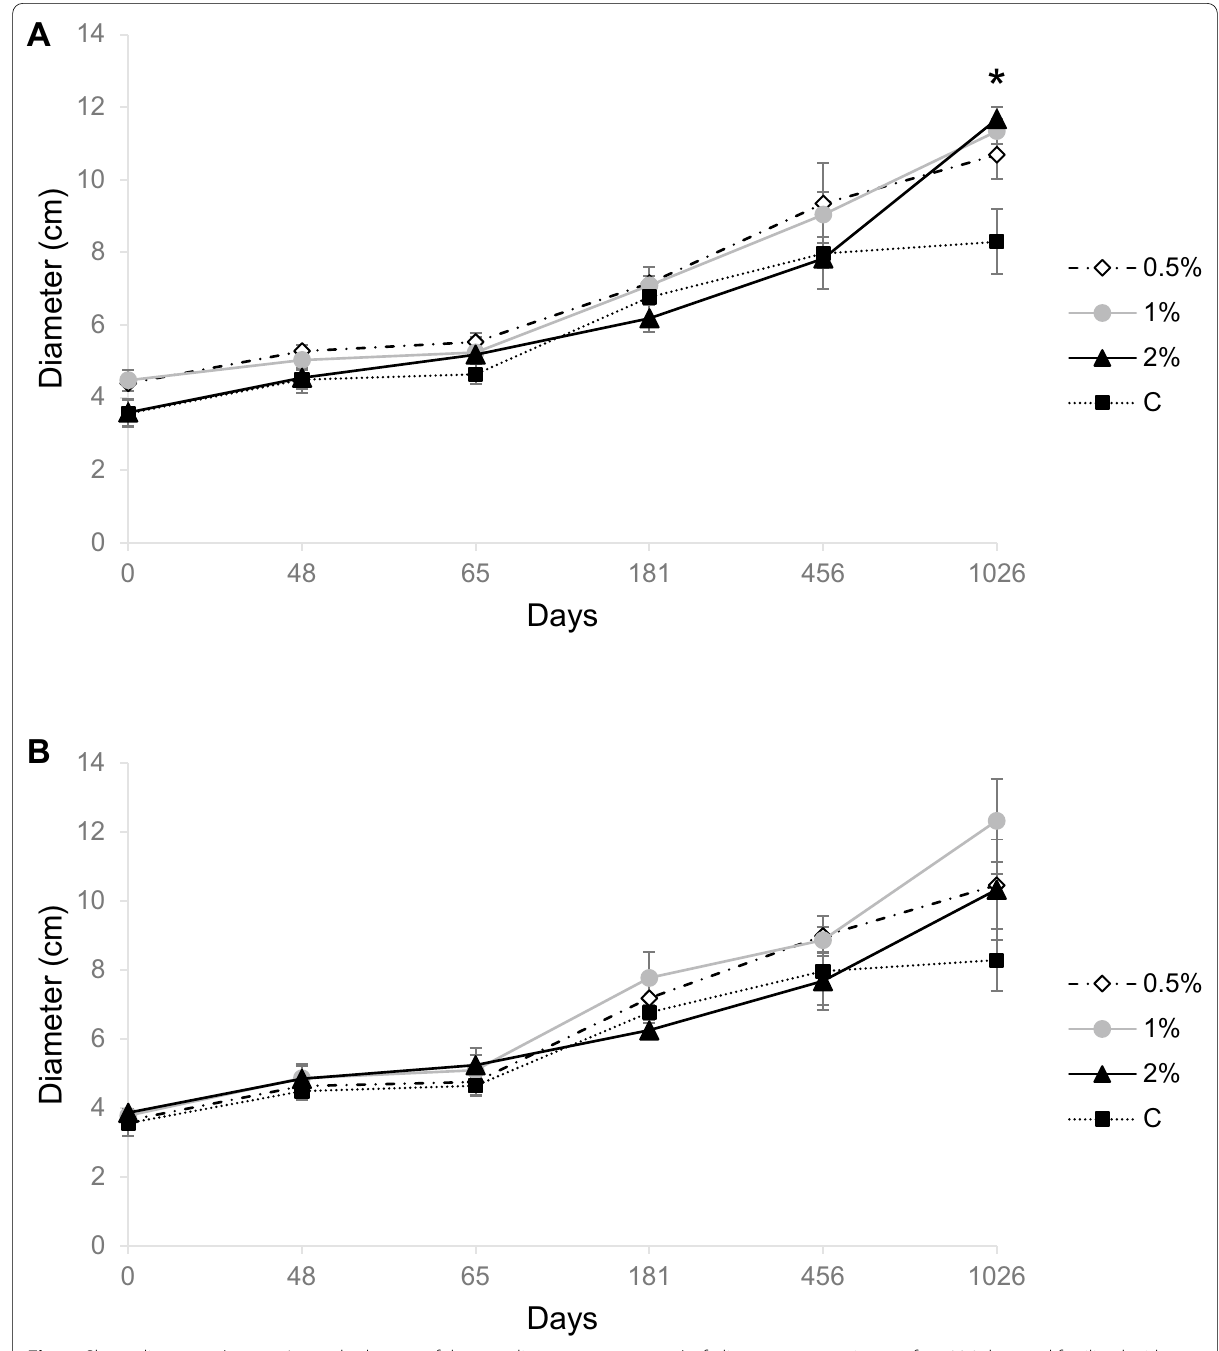
Fig. 1 Shoot diameters (means standard errors of three replicates per treatment) of olive trees grown in pots for 1026 days and fertilized with ± two types of sheep wool residues (SWR). A white wool, WW, and B black wool, BW, used at 4 different SWR/soil percentages: 0 (C), 0.5, 1.0, 2.0%. The asterisk indicates least significant differences (LSD) between treatments and control ( P <